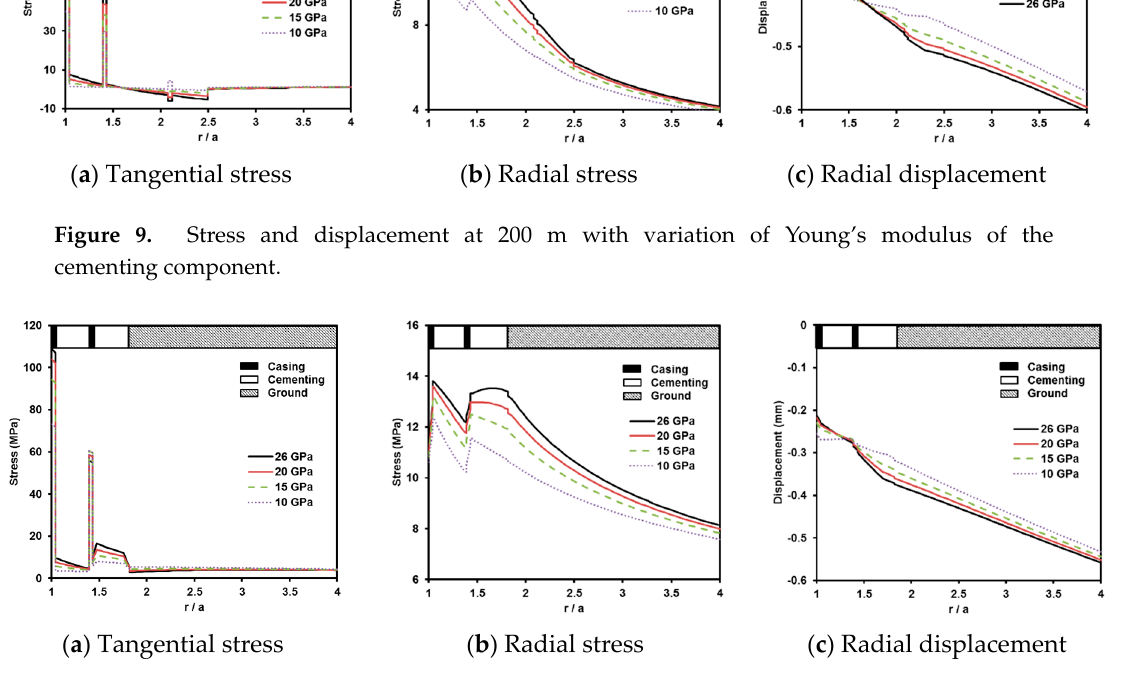
Figure 10. Stress and displacement at 1000 m with variation of Young’s modulus of the cementing component.